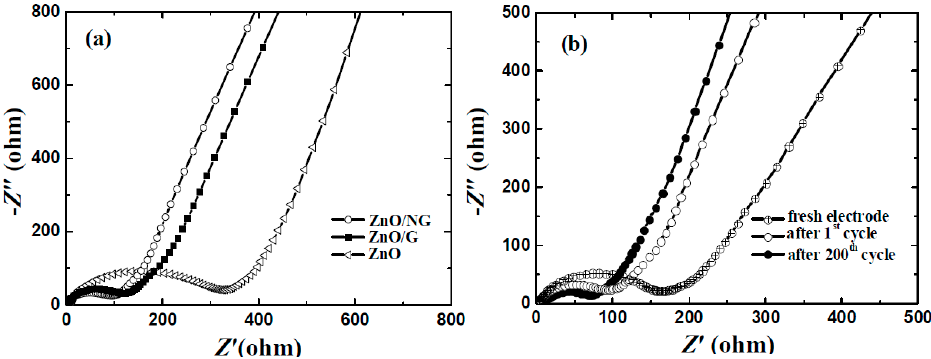
Figure 6. Nyquist plots of ( a ) ZnO, ZnO/G and ZnO/NG electrodes after first discharge/charge cycle; and ( b ) ZnO/NG electrode at different stages with the frequency region of 100 kHz to 0.01 Hz.